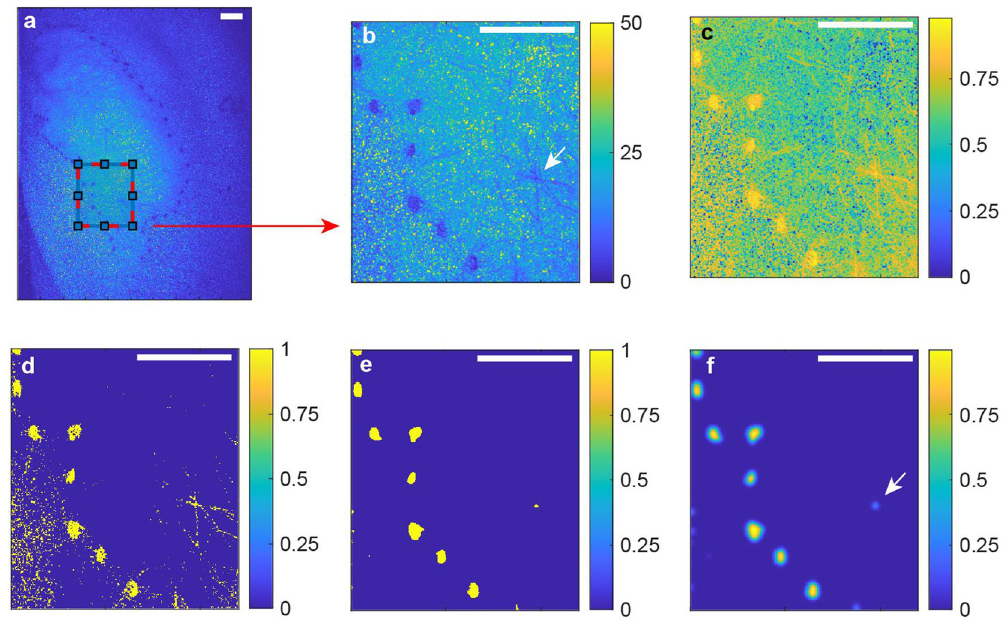
Figure 3. Marker segmentation in a speckle intensity frame. ( a ) Full frame speckle pattern including boundary markers. Scale bars, 10 mm. ( b ) Cropped area shown in ( a ) with a maximum value of 255. ( c ) Normalized and inverted version of ( b ). ( d ) Threshold version of ( c ) including a speckle pattern. ( e ) Mean separation segmentation. ( f ) Gaussian filtering. White arrows indicate a natural landmark formed by intersection of